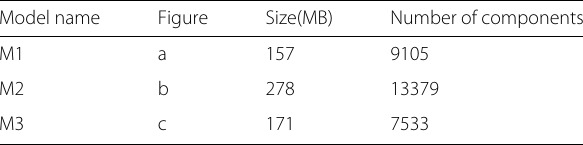
Table 1 Basic information for the three test industry foundation classes models